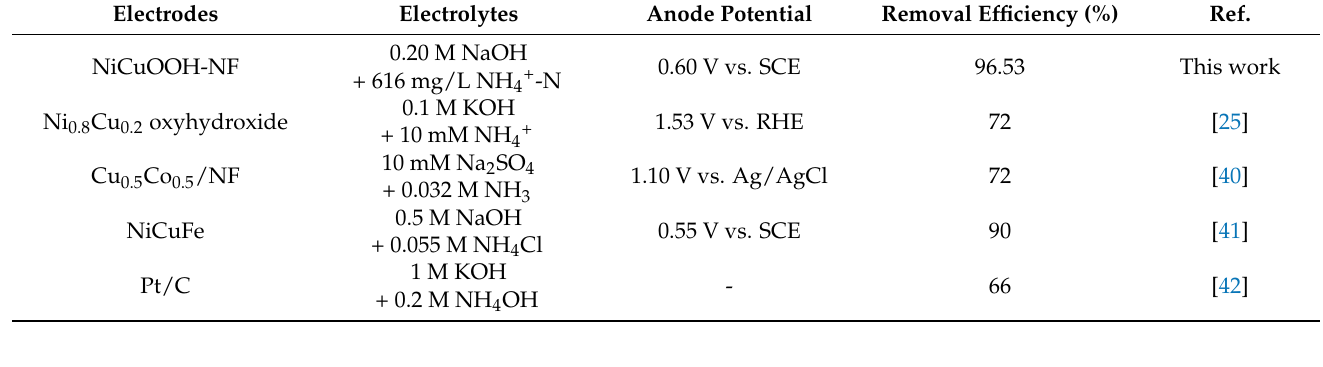
Table 2. The removal efficiency of NH 4+ -N with different electrodes.